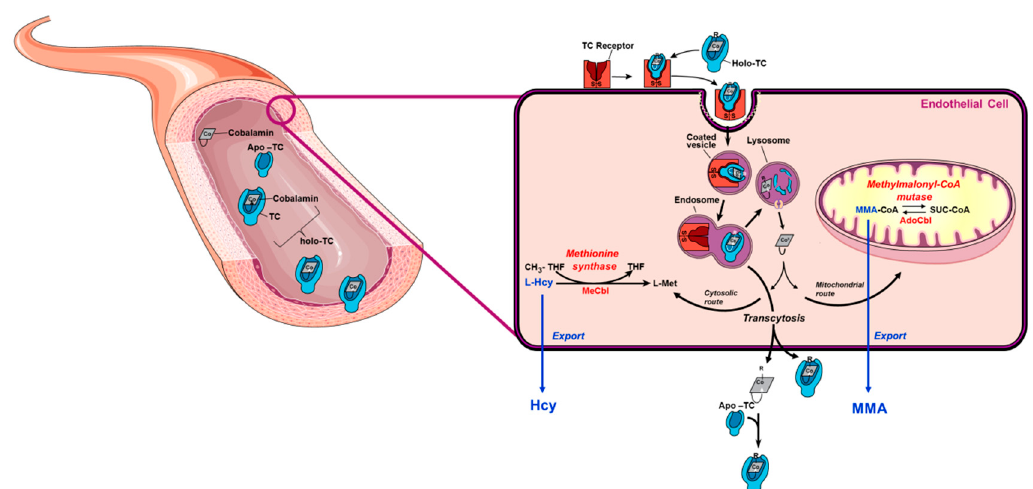
Figure 1. Vitamin B 12 metabolism. Dietary vitamin B 12 is transported through the digestive system and absorbed in the intestine where it binds to apo-transcobalamin (apo-TC) to form holotranscobalamin (holo-TC). Holo-TC is the bioactive form of vitamin B 12 . Holo-TC reaches circulation and it is then taken up by all cells in the body via receptor-mediated endocytosis (the transcobalamin (TC) receptor is also known as CD320). Once in the cell, vitamin B 12 is freed from TC in the lysosome and exported into the cytosol. Downstream cytosolic processing and tra ffi cking events ensure that vitamin B 12 ultimately reaches cytosolic methionine synthase and mitochondrial methylmalonyl-CoA mutase. Nutritional deficiency of vitamin B 12 blocks the reactions catalyzed by methionine synthase and methylmalonyl-CoA, resulting in the accumulation of their respective substrates, homocysteine (Hcy) and methylmalonyl-CoA (MMA-CoA). Hcy and MMA are toxic to cell metabolism; therefore, cells export these metabolites into circulation under conditions of B 12 deficiency. This manifests clinically as elevated concentration of Hcy and MMA in plasma or serum. A vascular endothelial cell is used as a generic model. This figure was modified from reference